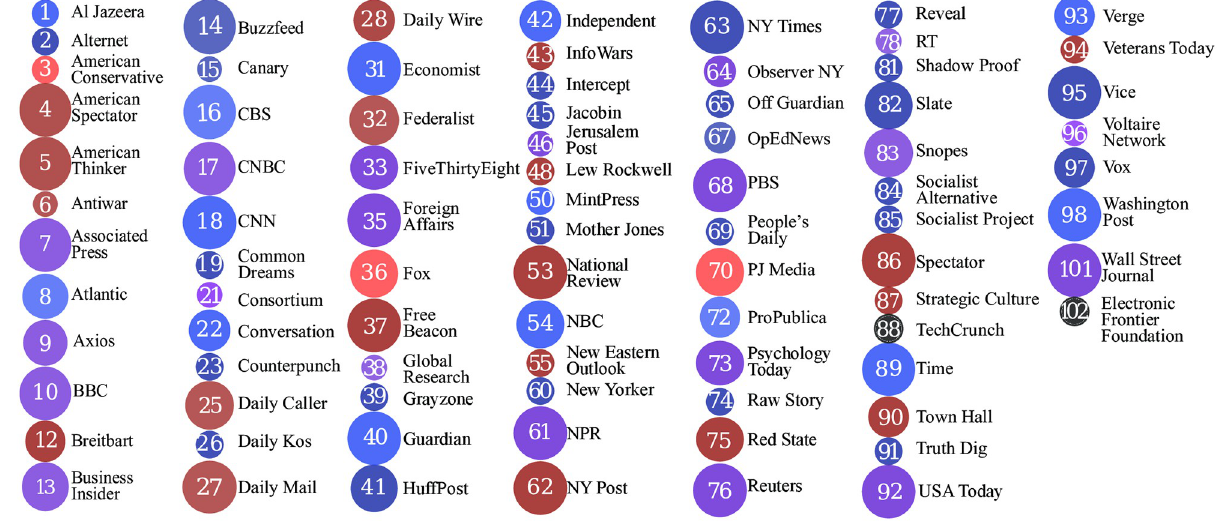
Fig 2. Media legend for generalized principle component